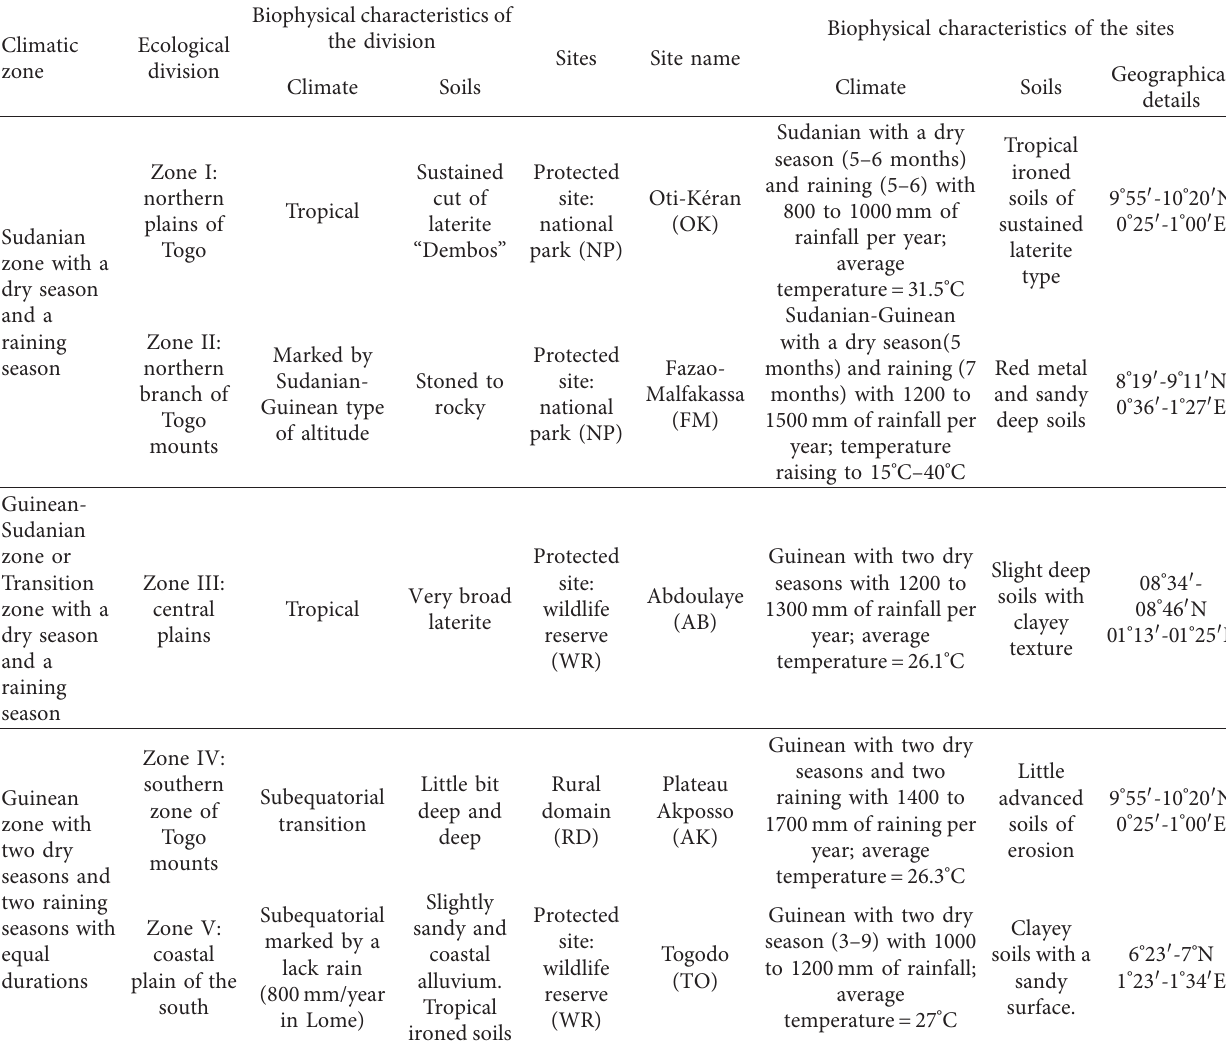
Table 1: Biophysical characteristics of study zones and